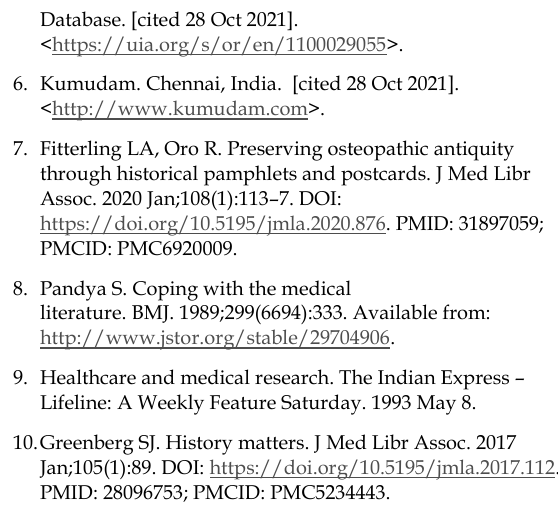
Supplemental Figure 1. SMLRT services current Supplemental Figure 2. SMLRT services current literature listings, Aug-Sep 1986 Supplemental Figure 3. Current medical literature access copy request form Supplemental Figure 4. Desktop publishing in 1987 Supplemental Figure 5. Desktop publishing in 1987 illustration Supplemental Figure 6. Media coverage about SMLRT Supplemental Figure 7. Samples of current literature Supplemental Figure 8. Some of the committee members, 1990 Supplemental Figure 9. Article in The BMJ in 1989 about SMLRT Supplemental Figure 10. Covers of informed Supplemental Figure 11. Samples of abstracts, March